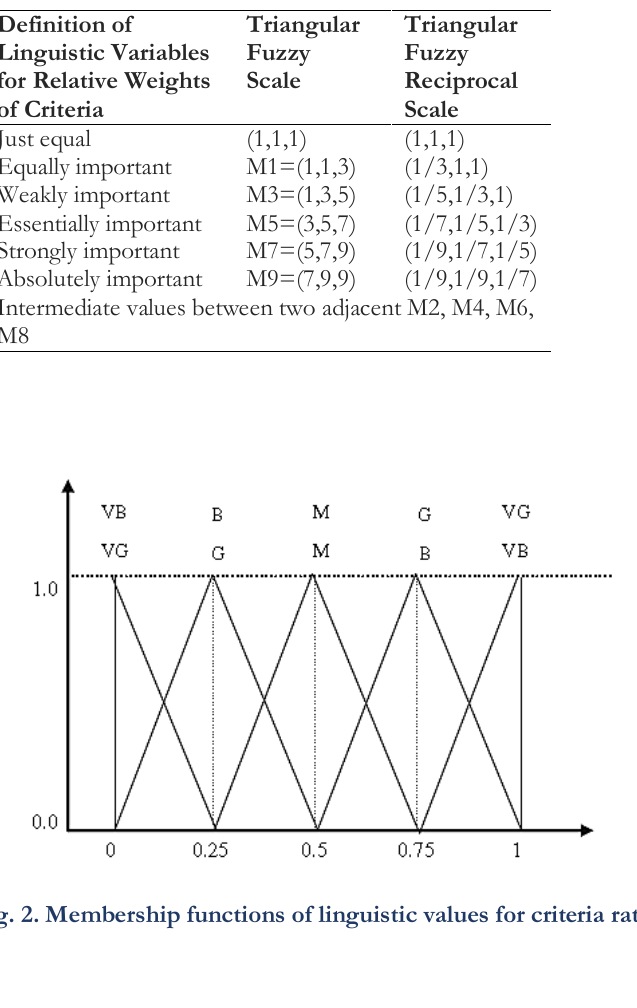
Table 3. Linguistic values and mean of fuzzy numbers for alternatives.